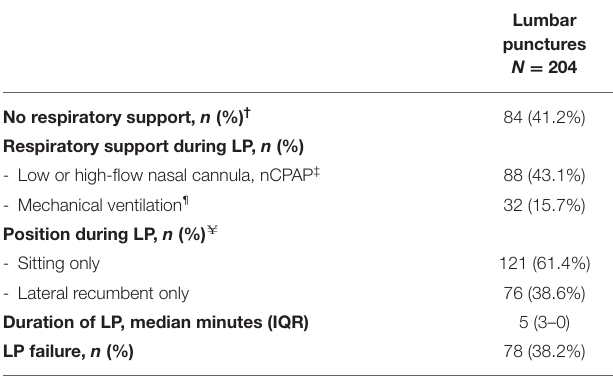
TABLE 2 | Respiratory support, position during lumbar puncture and additional information on performing lumbar puncture.